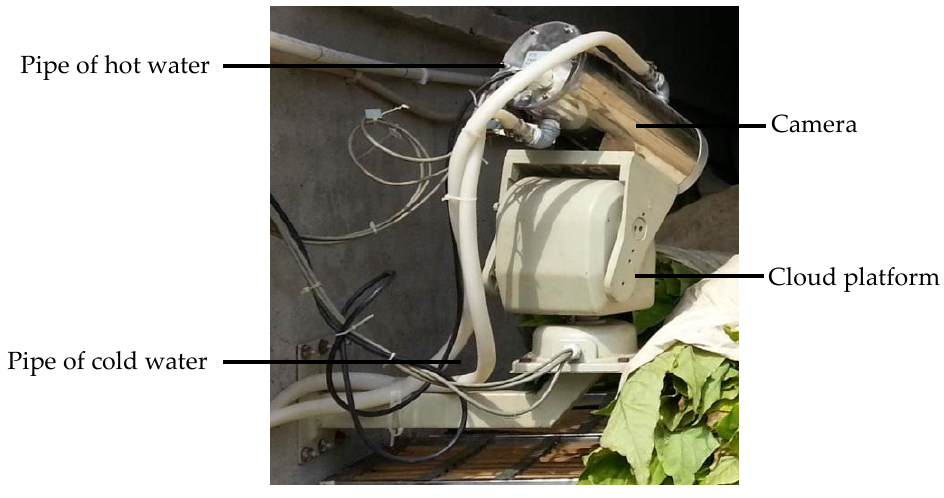
Figure 4. Image sampling set-up.